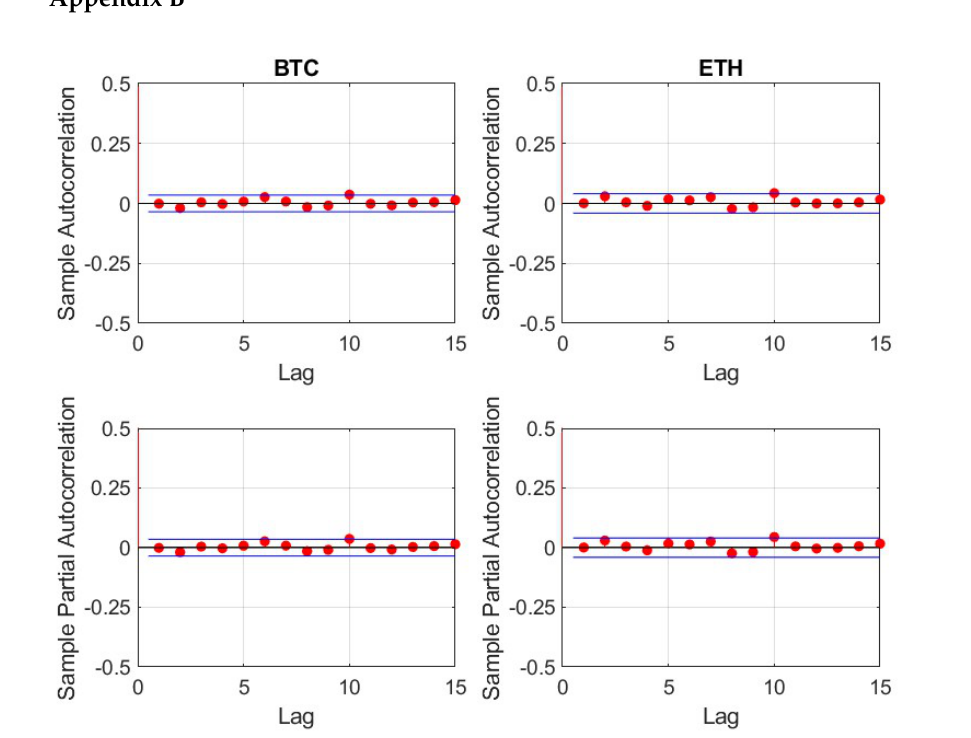
Figure A8. BTC’s and ETH’s residuals’ autocorrelation.